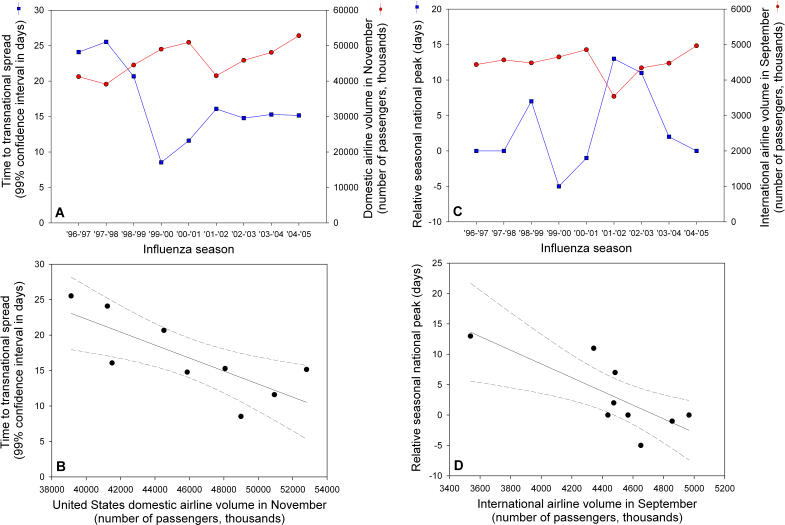
Influence of United States Airline Volume on Influenza Spread and the Timing of Yearly Transmission(A) November domestic air travel volume (red line) is estimated by the total number of passengers on domestic flights. Duration to transnational spread of influenza (blue line) is estimated as the 99% confidence intervals for differences between the estimated seasonal curves of influenza mortality for each of nine major geographic regions of the United States.(B) The association between domestic airline travel in November and transnational spread is displayed. The numbers of traveling domestic passengers in November significantly predicts transnational influenza spread (f = 10.6; r
 2 = 0.60; slope = −0.94 days/million passengers; p = 0.014).(C) September international air travel volume (red line) is estimated by the total number of passengers on international flights. The timing of seasonal national influenza mortality (blue line) is estimated as the peak date of influenza mortality from the filtered national curve. The timing displayed is relative to the average date of February 17.(D) The association between international airline travel in September and the timing of the US influenza peak is displayed. The numbers of traveling international passengers in September significantly predicts the timing of seasonal influenza mortality (f = 10.0; r
 2 = 0.59; slope = −11.3 days/million passengers; p = 0.016).